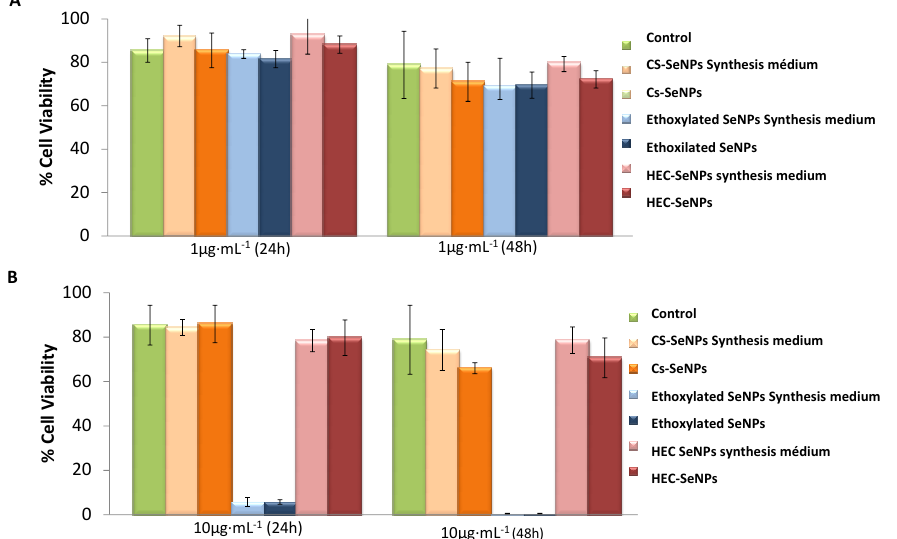
Figure 3. Percentages of cell viability of L. d. bulgaricus LB-12 after treatment with SeNPs at two level of exposure ( A ) 1 μ g Se mL − 1 and ( B ) 10 μ g Se mL − 1 . Data are expressed as mean ± standard error N = 3 replicates.